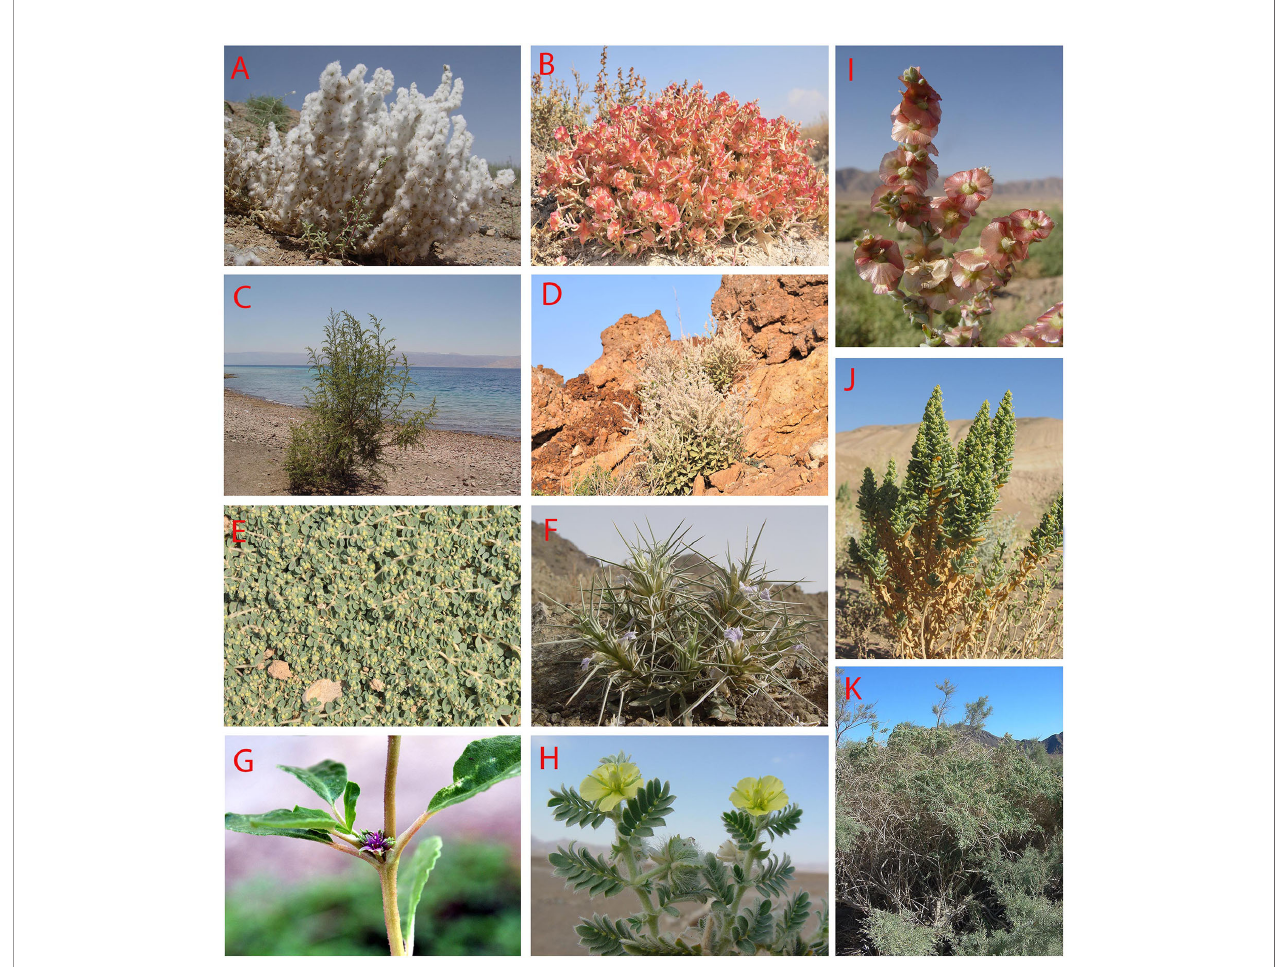
FIGURE 10 | (A – K) : Some representatives of important C 4 Eudicot lineages in Southwest (SW) Asia: (A) Bassia eriantha (Fisch. and C.A. Mey.) Kuntze, 10.6.2004, Artemisia + Stipagrostis semi-desert steppe, 50 km SE Esfahan, Iran; (B) Anabasis fi rouzii Akhani, 10.10.2012, marl slopes, Qorkhod Protected Area, N. Khorassan, Iran; (C) Suaeda monoica Forssk. ex J.F. Gmel. 18.6.2007, Red Sea coasts, Aqabeh, Jordan; (D) Aerva javanica (Burm.f.) Juss. ex Schult. 22.2.2013, rocky slopes, Hormoz Island, Persian Gulf; (E) Euphorbia serpens Kunth, 3.7.2014, ruderal soil, Khuzestan, Iran; (F) Blepharis ciliaris (L.) B.L. Burtt, 22.2.2013, gravely-sandy soils, Hormoz Island, Persian Gulf; (G) Trianthema portulacastrum L., 23.2.2013, ruderal places, Hormoz Island, Persian Gulf; (H) Tribulus macropterus Boiss. 18.9.2001, Khuzestan, Iran; (I) Climacoptera chorassanica Pratov, 1.9.2003, hypersaline soils, 40 km SE Birjand, Khorassan, Iran; (J) Bienertia kavirense Akhani, 5.8.2016, Esfahan/Semnan, Iran; (K) Caroxylon abarghuense (Assadi) Akhani and Roalson, 5.10.2001, Touran protected Area, Iran (photos by H.